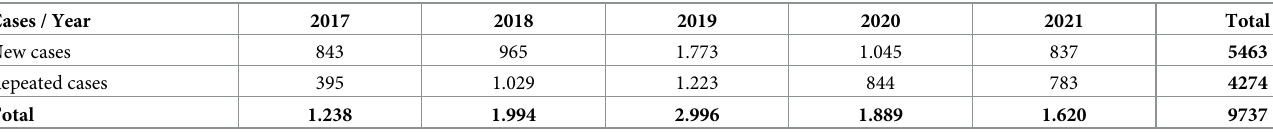
Table 1. New and repeated cases of sleep apnea in children and adolescents, Colombia, 2017–2021. Cases / Year